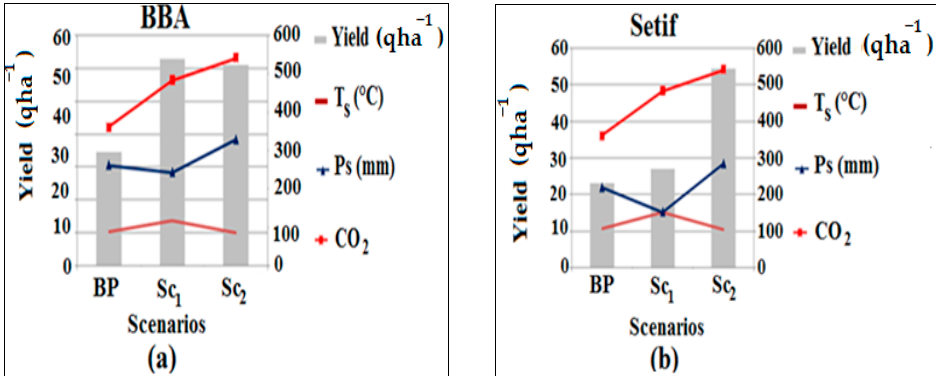
Figure 4. ( a , b ) Impact of future change in seasonal temperatures, precipitations, and CO 2 concen- trations on Mexicali cultivar grain yield at BBA and Setif sites.